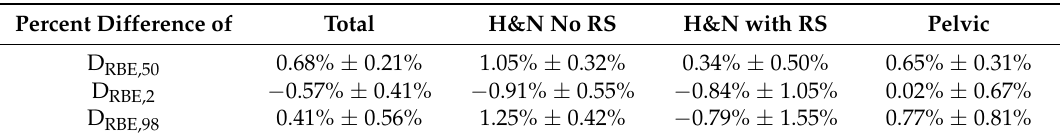
Table 4. Average percent variation of target D RBE,50 , D RBE,2 , and D RBE,98 , with respect to MC calculations for proton patient cases. The values represent the mean ± standard error of the mean.